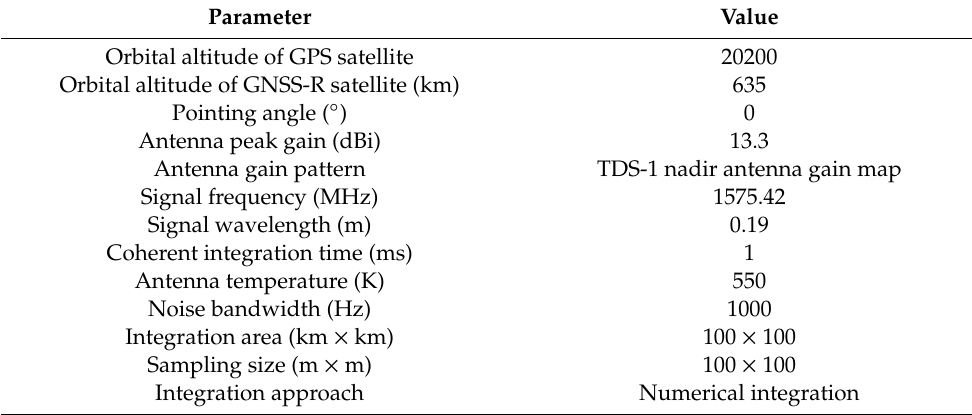
Table 1. Related parameter settings when calculating signal-to-noise ratio (SNR) through Equation